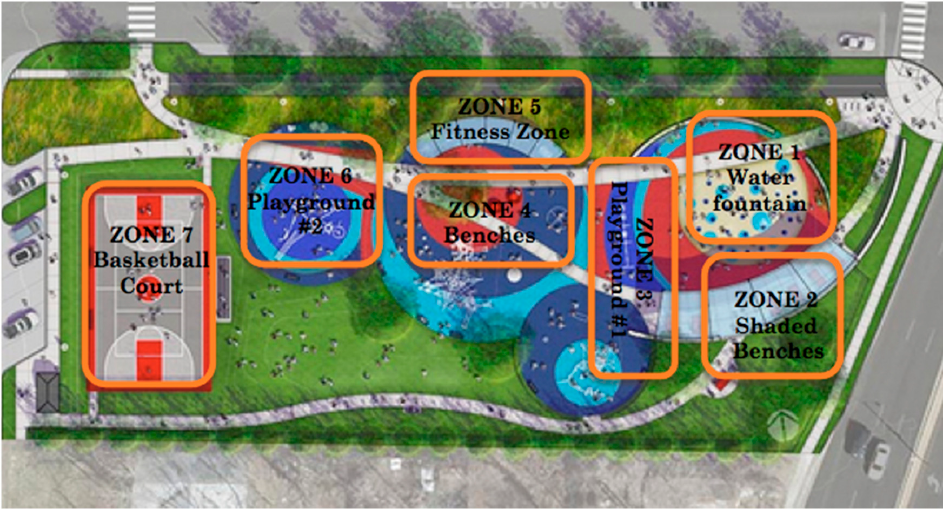
Figure 1. Map of Trojan Park divided into seven zones for scanning.